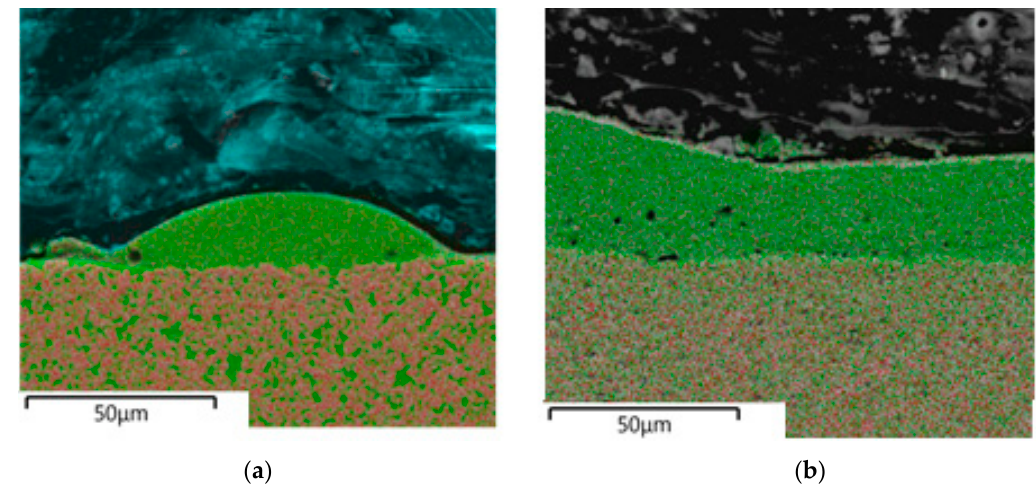
Figure 6. Cross sections of fused samples: ( a ) single track at H = 20 μ m, P = 70 W, and V = 300 mm/s; ( b ) monolayer at H = 35 μ m, P = 70 W, V = 300 mm/s, s = 50 μ m.